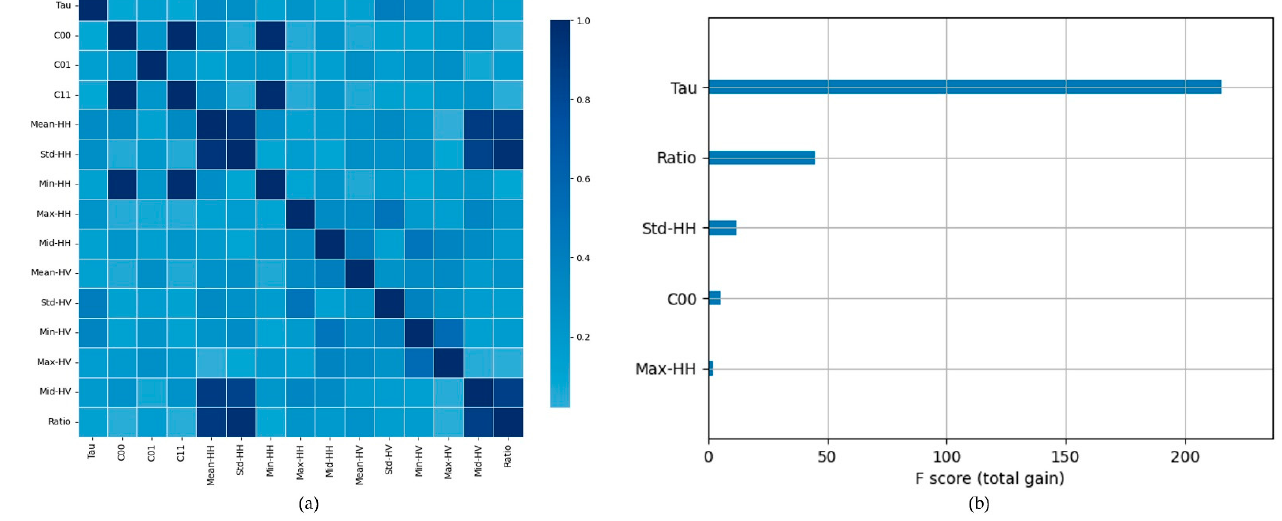
Figure 7. ( a ) Feature relevance (Tau denotes texture); ( b ) the top five most important features.